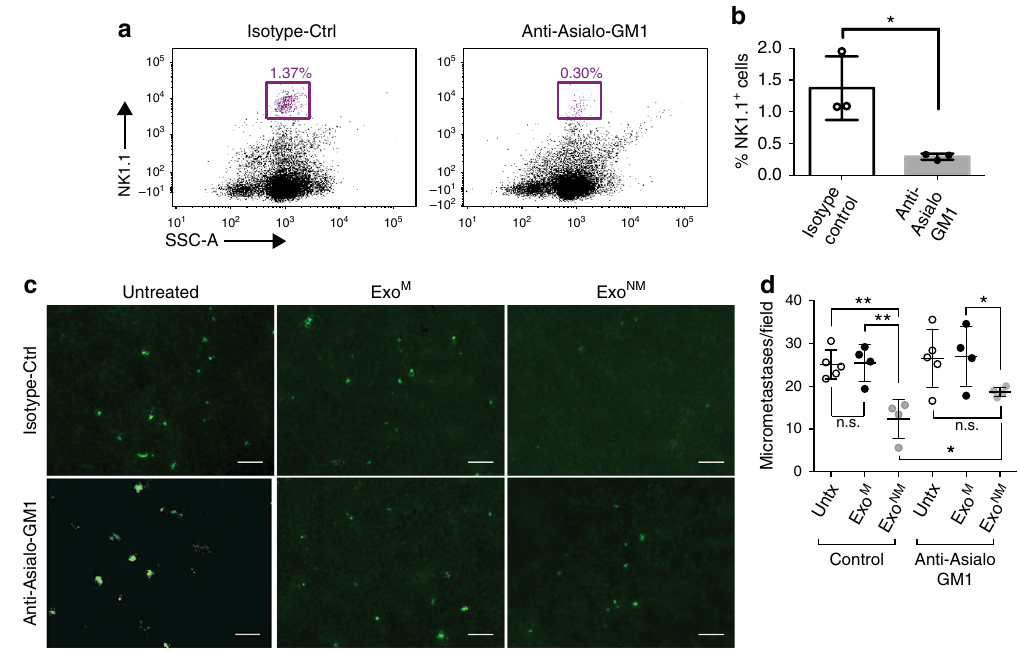
Fig. 4 NK cells contribute to exosome-driven tumor cell clearance. a , b C57BL/6 mice were subjected to NK cell depletion with an anti-asialo GM1 antibody and NK cell depletion assessed by fl ow cytometry with NK1.1 antibody. a Flow plots showing percent NK cells in the spleens of mice 96 h after treatment with isotype control or anti-asialo GM1 antibody. b Quanti fi cation of the analysis shown in a . * P < 0.05 by two-sided t -test ( n = 3). Mean and s.d. values are shown. c , d Following NK cell depletion, mice were treated with the indicated exosomes and used in an extravasation assay with CFSE-tagged B16F10 cells as described above. c Extravasation images taken 24 h after melanoma cell inoculation. Scale bar: 100 μ m. d Quanti fi cation of experiment in c . Data are expressed as numbers of extravasated cells per high-powered fi eld ( n = 4, fi ve random images per animal analyzed for each condition). * P < 0.05 and ** P < 0.01 calculated by Tukey ’ s multiple comparison with (Bonferroni post-test); n.s., non-signi fi cant. Median and s.d. values are